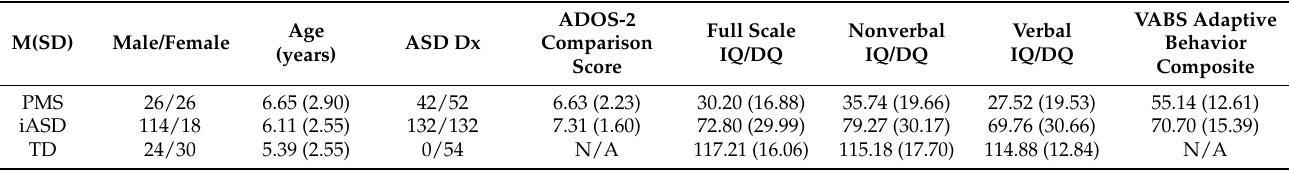
Table 1. Participant demographics. ADOS-2 comparison scores range from 1–10 with higher numbers reflecting greater symptom